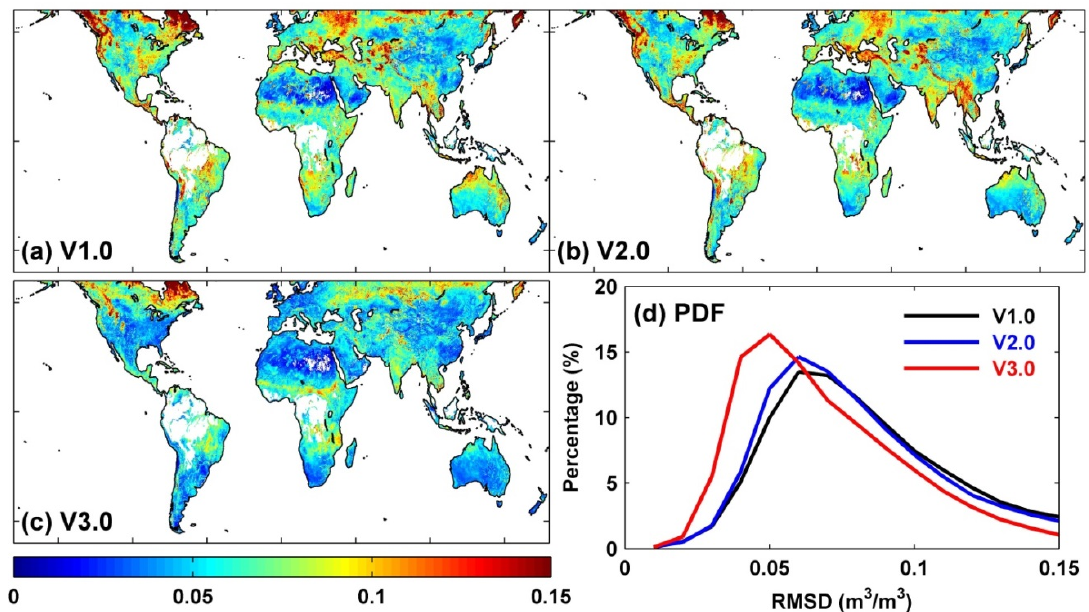
Figure 6. With respect to the European Space Agency’s Climate Change Initiative (ESA_CCI) observations, root mean square differences (RMSDs in m 3 /m 3 unit) for ( a ) SMOPS version 1.0 over the 1 June 2007–3 November 2011 period, ( b ) SMOPS version 2.0 over the 16 November 2011–20 September 2016 period, ( c ) SMOPS version 3.0 over the 1 April 2015–31 December 2019 period, as well as ( d ) global domain-averaged frequency probability as a function of RMSD for the three versions SMOPS blended soil moisture data products during the corresponding product time periods with curves shifting toward the left (right) indicating lower (greater) errors.